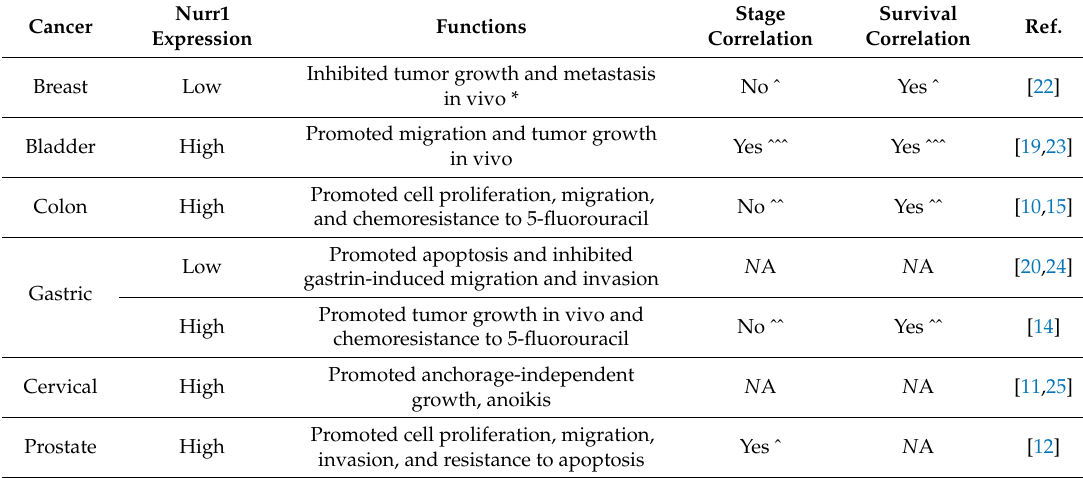
Table 1. Summary of Nurr1 expression and its associated functions and clinicopathological correlation in